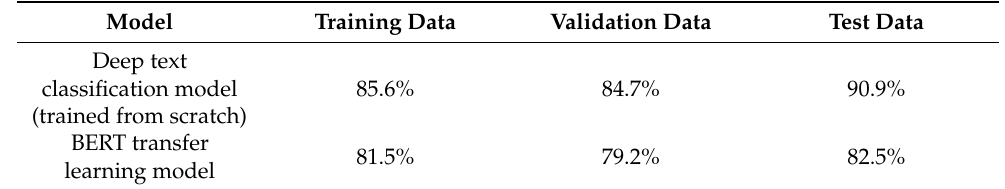
Table 6. Discriminatory power, AUC.